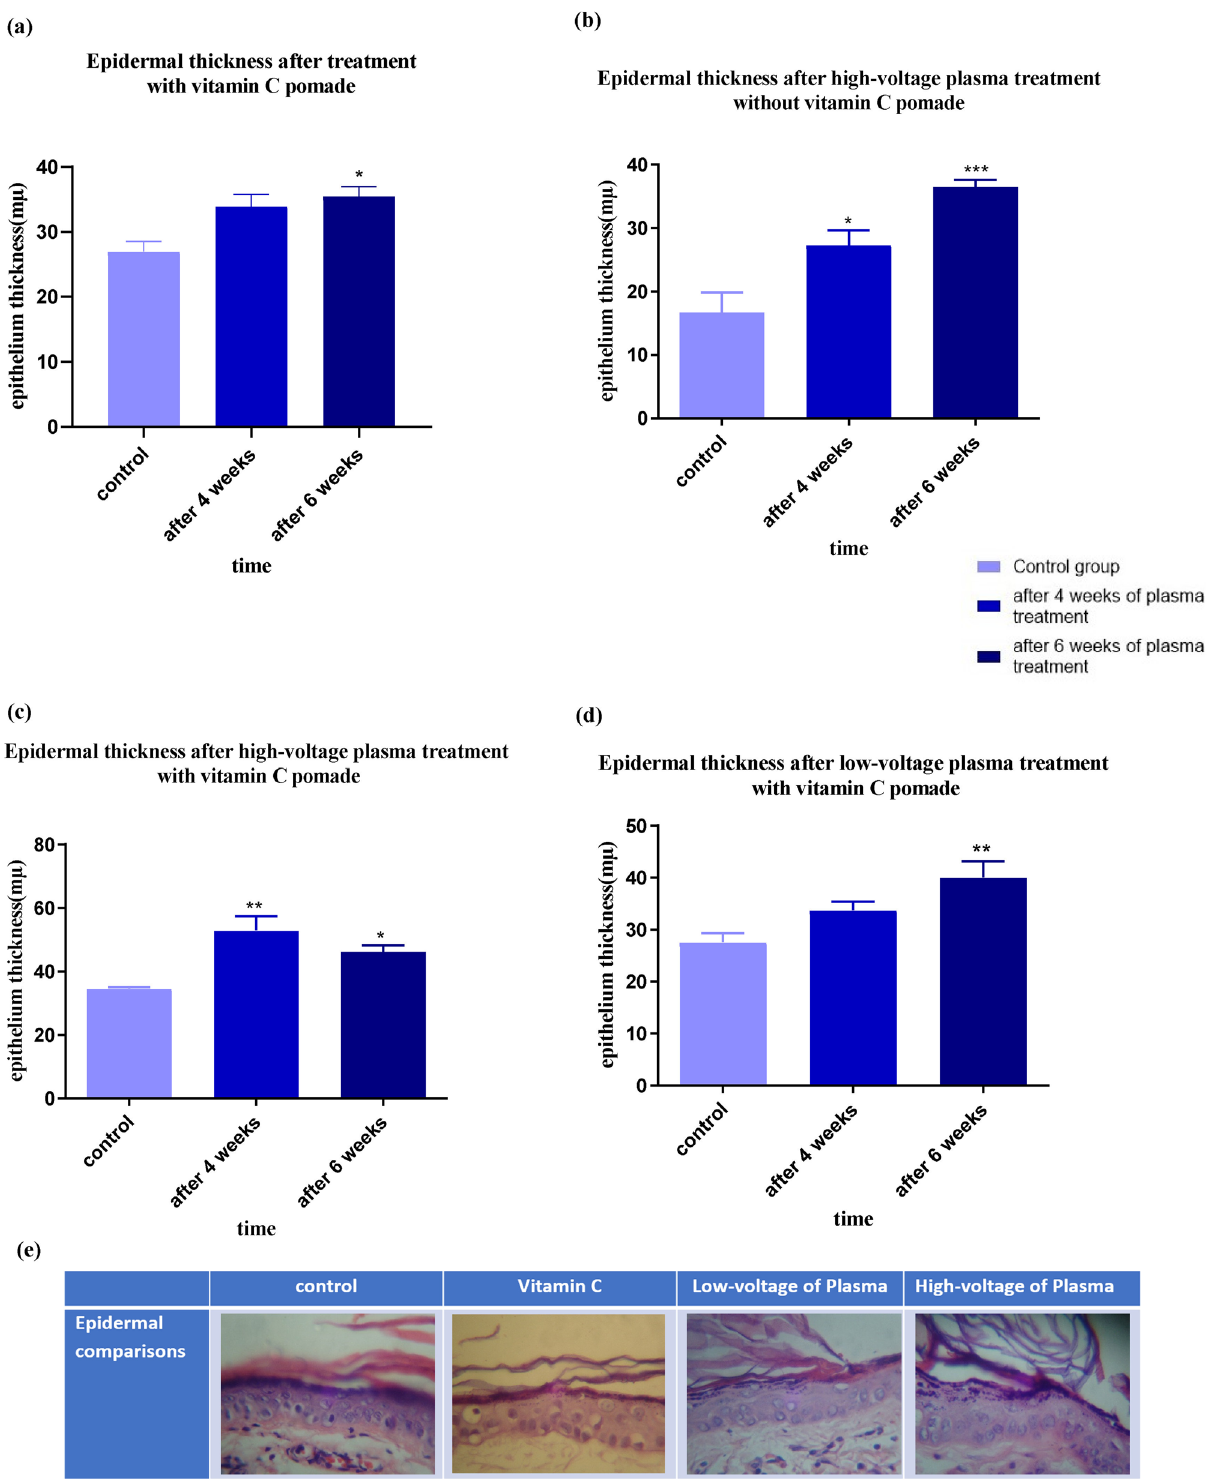
Figure 7. Epidermal thickness after 4 and 6 weeks of ( a ) treatment with vitamin C, ( b ) high-voltage plasma treatment without vitamin C pomade, ( c ) high-voltage plasma treatment with vitamin C pomade, ( d ) low- voltage plasma treatment with vitamin C pomade, ( e ) the histopathological images of the epidermis layer of the treated areas (vitamin C, low voltage plasma and the high voltage plasma) compared to the controls (significant differences compared with the control group (without treatment skin), *p < 0.05, **p <